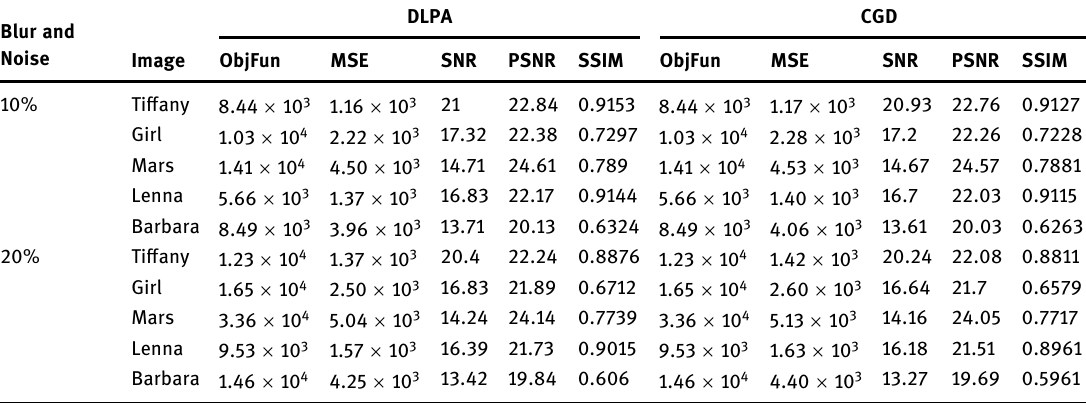
Table 2: Parameter value of the restored color images